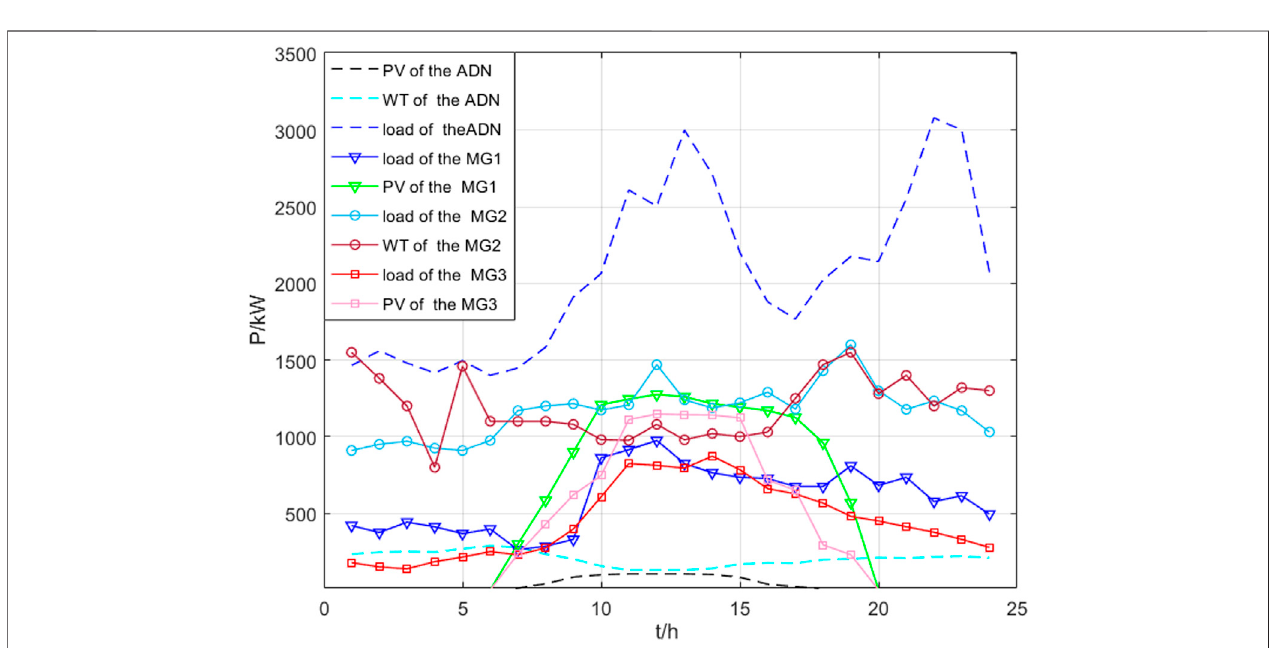
FIGURE 3 | Load and new energy output of the ADN with MGs.